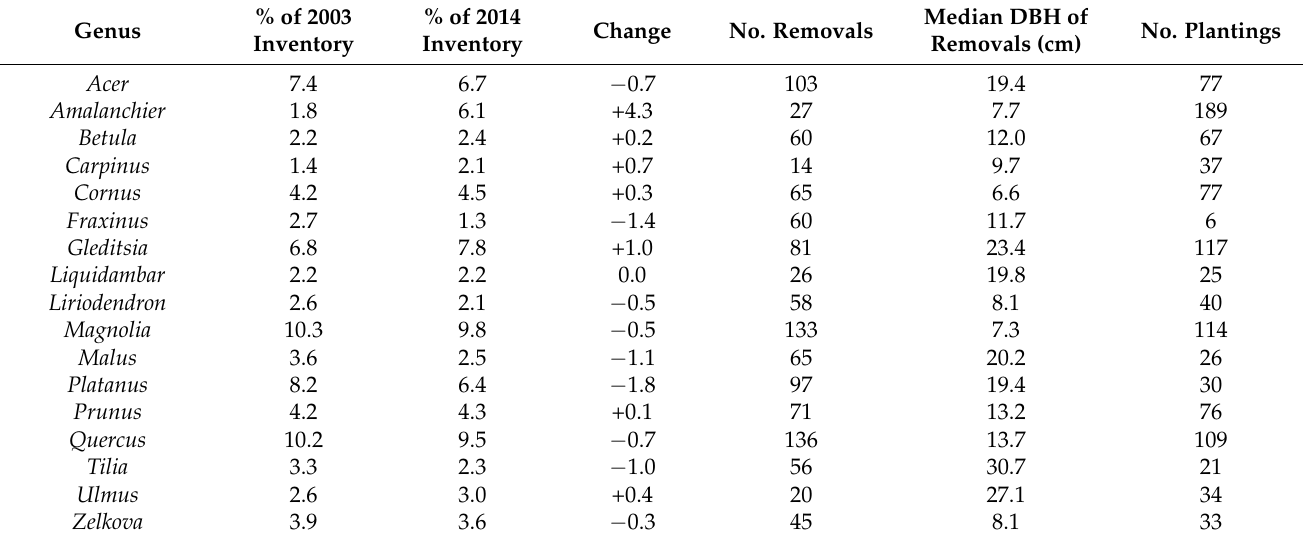
Table 5. Most common genera in 2003 and 2014. Only genera representing 2% or more of the total in each inventory are included. These 18 genera account for 79.8% of all trees in 2003 and 78.4% in